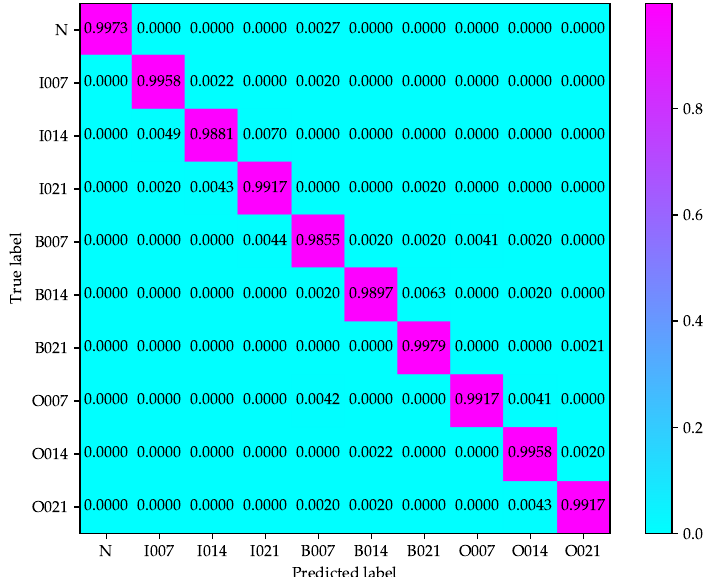
Figure 9. Confusion matrix of test samples used in the improved 2D LeNet-5